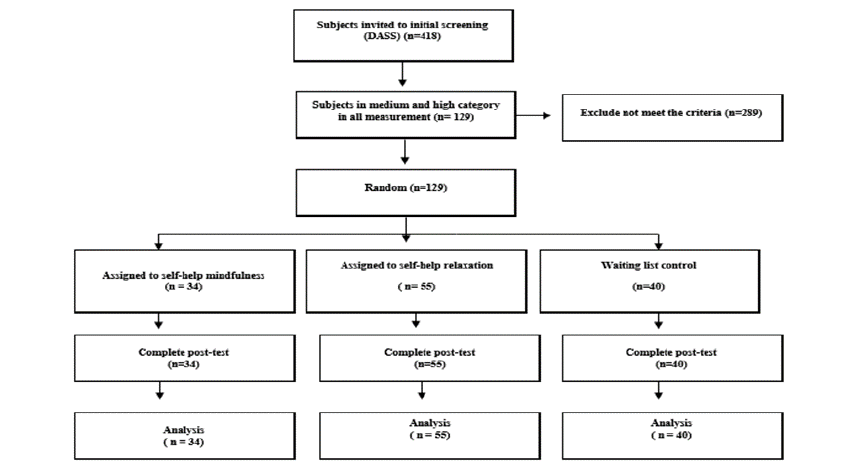
Figure 1. Sample Selection and Redention of Study (Figure with permission ©Suranata, et.,all